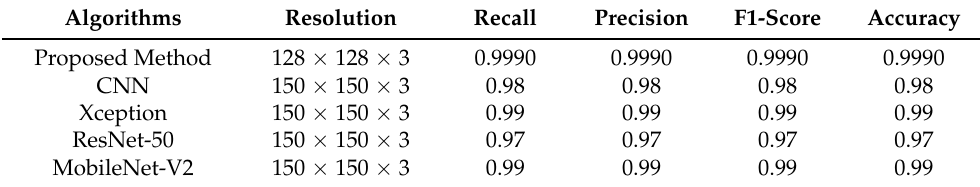
Table 12. Comparative analysis of the proposed method with the methods presented in [24].